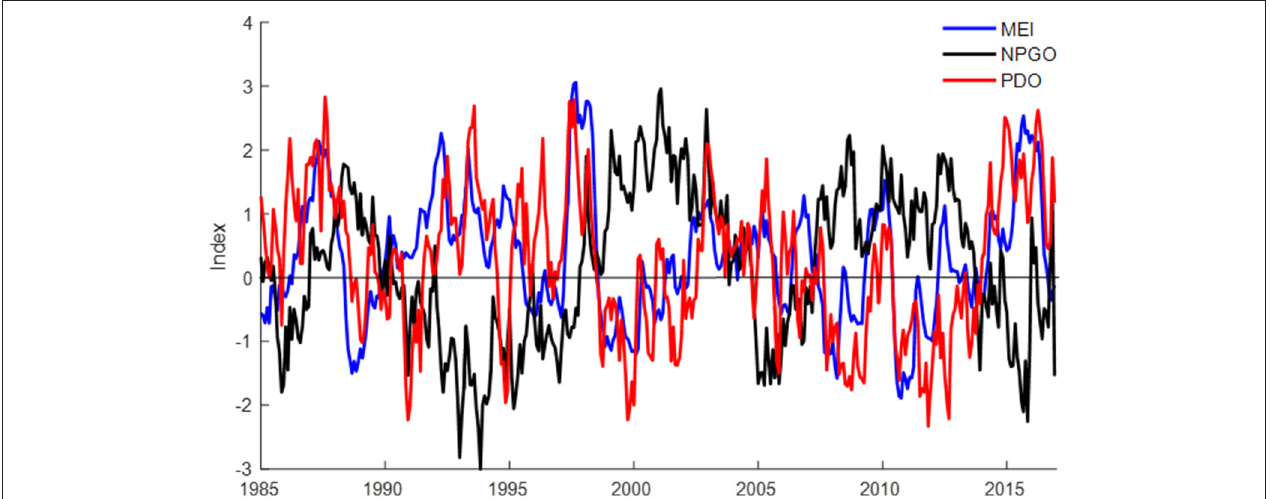
FIGURE 2 | Time series of climate indices including (a) the North Pacific Gyre Oscillation, NPGO; (b) the Multivariate ENSO Index, MEI; and (c) the Pacific Decadal Oscillation, PDO. Data sources are included in Methods. All series were smoothed using a 12-month LOESS filter.